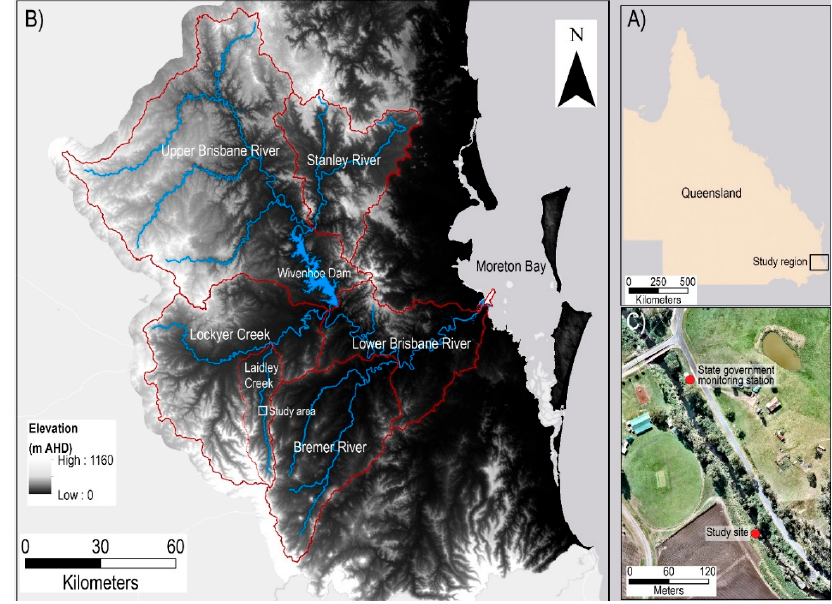
Figure 2. Study site location relative to ( A ) Queensland, Australia; ( B ) Brisbane River catchment in South East Queensland (sub-catchments indicated in red outlines) and ( C ) long-term State Government monitoring station: Laidley Creek at Mulgowie gauging station (No. 143209B). Elevation referenced to Australian Height Datum (AHD).